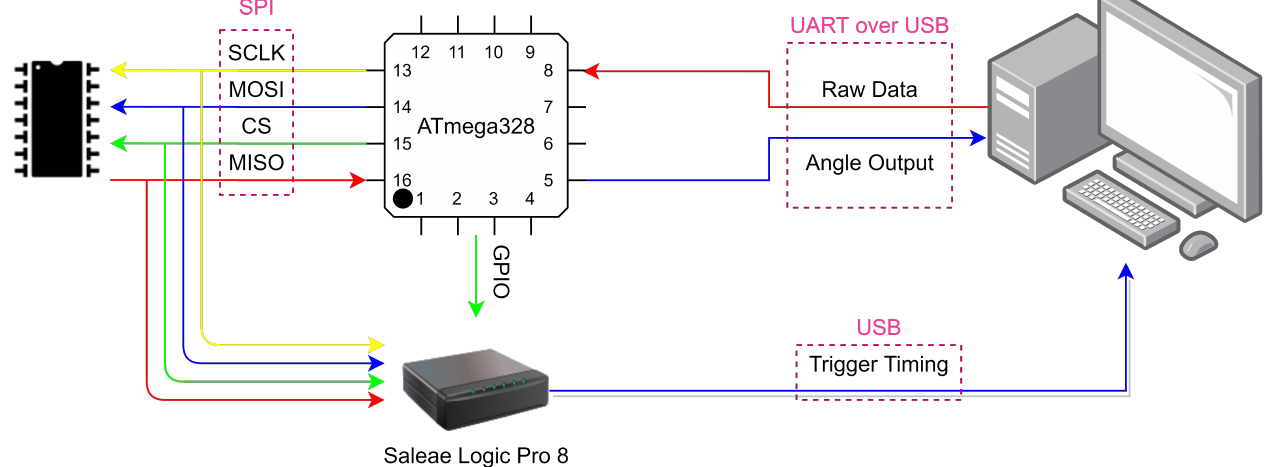
Figure 7. Test configuration 2 system architecture to determine sensor refresh